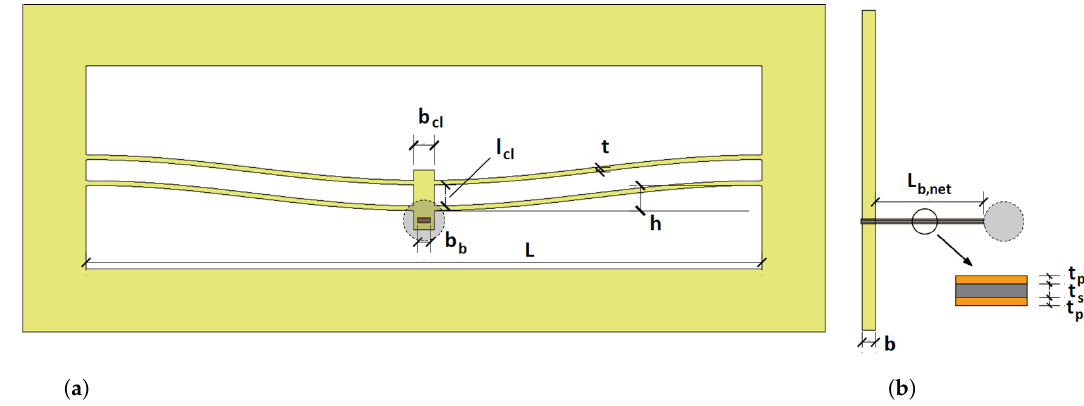
Figure 2. Representation of the designed prototype in frontal ( a ) and lateral view ( b ). Model A is without the tip mass (grey sphere), model B includes the tip